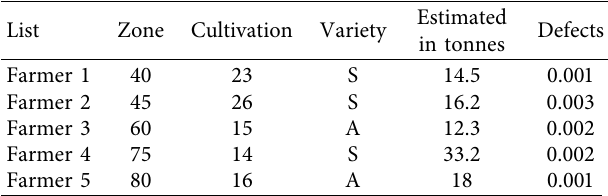
Table 5: Potato crop yields for numerous farms in Bekaa Valley’s various